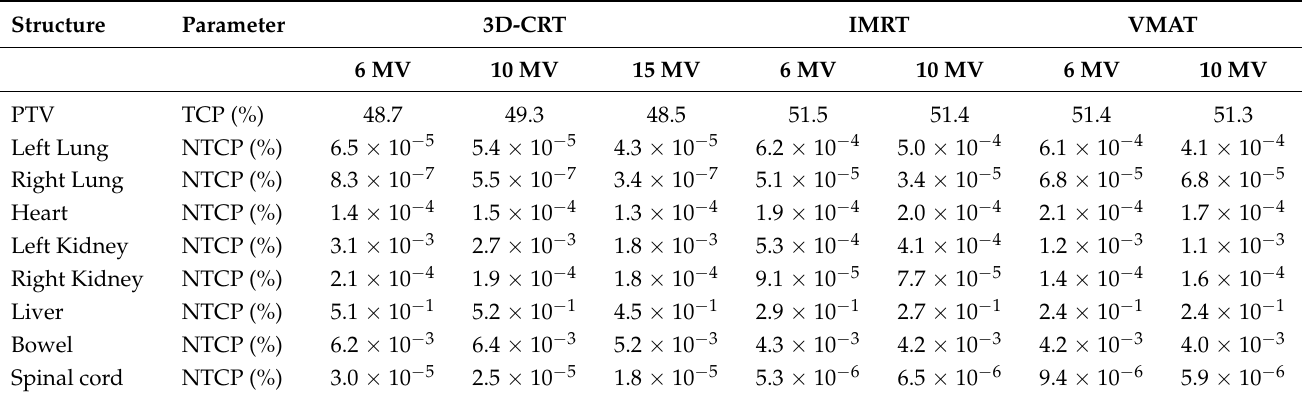
Table 6. TCP and NTCP calculations derived from radiation therapy plans for gastric cancer on a computational phantom representing an adult female